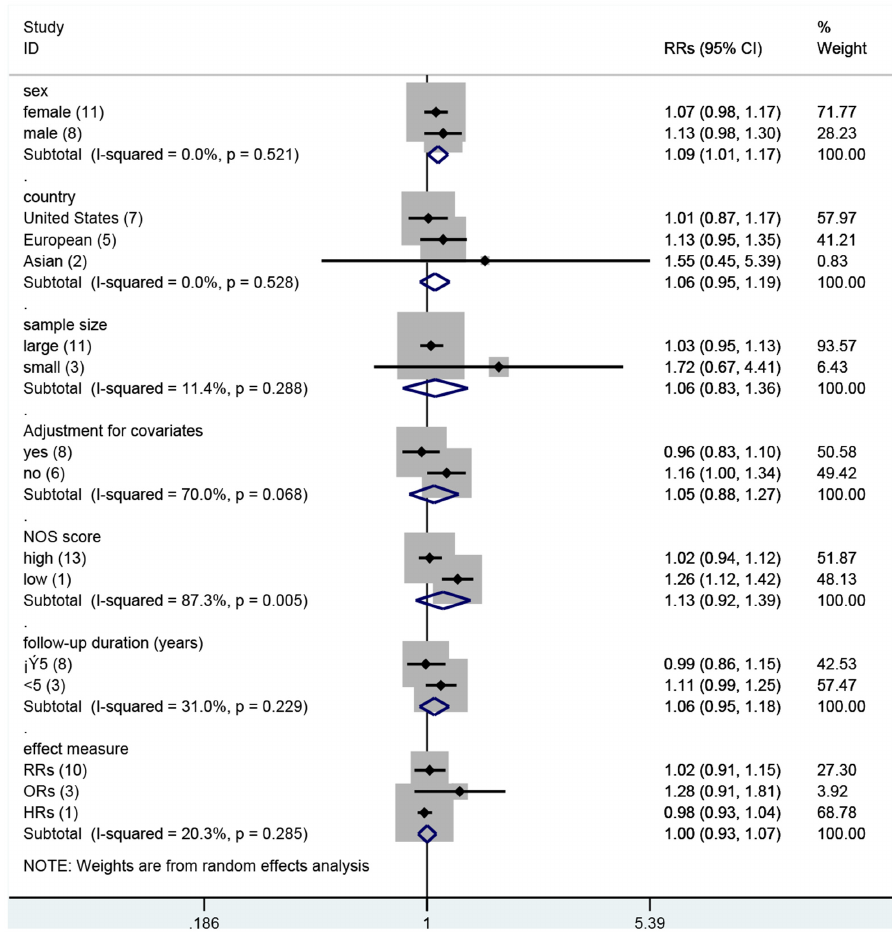
Fig 4. Sensitivity analyses based on various exclusion criteria.